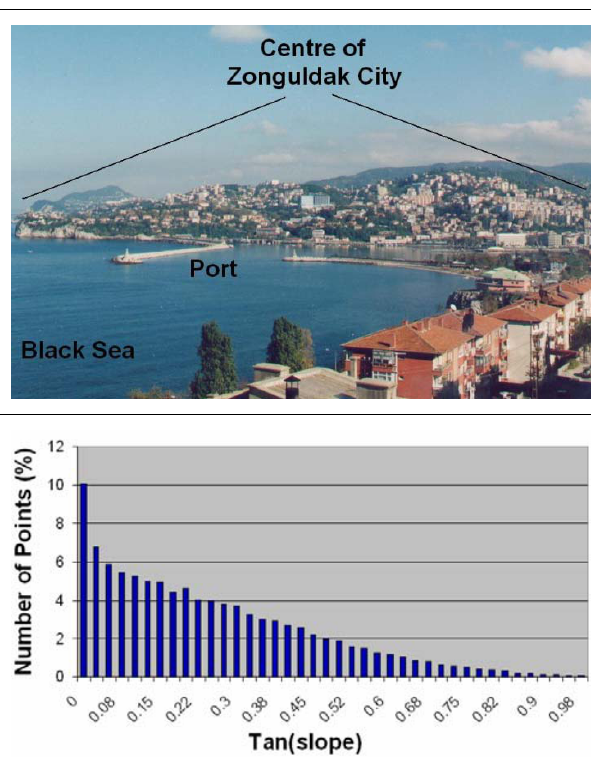
Figure 2. Zonguldak City and the frequency distribution of terrain inclination